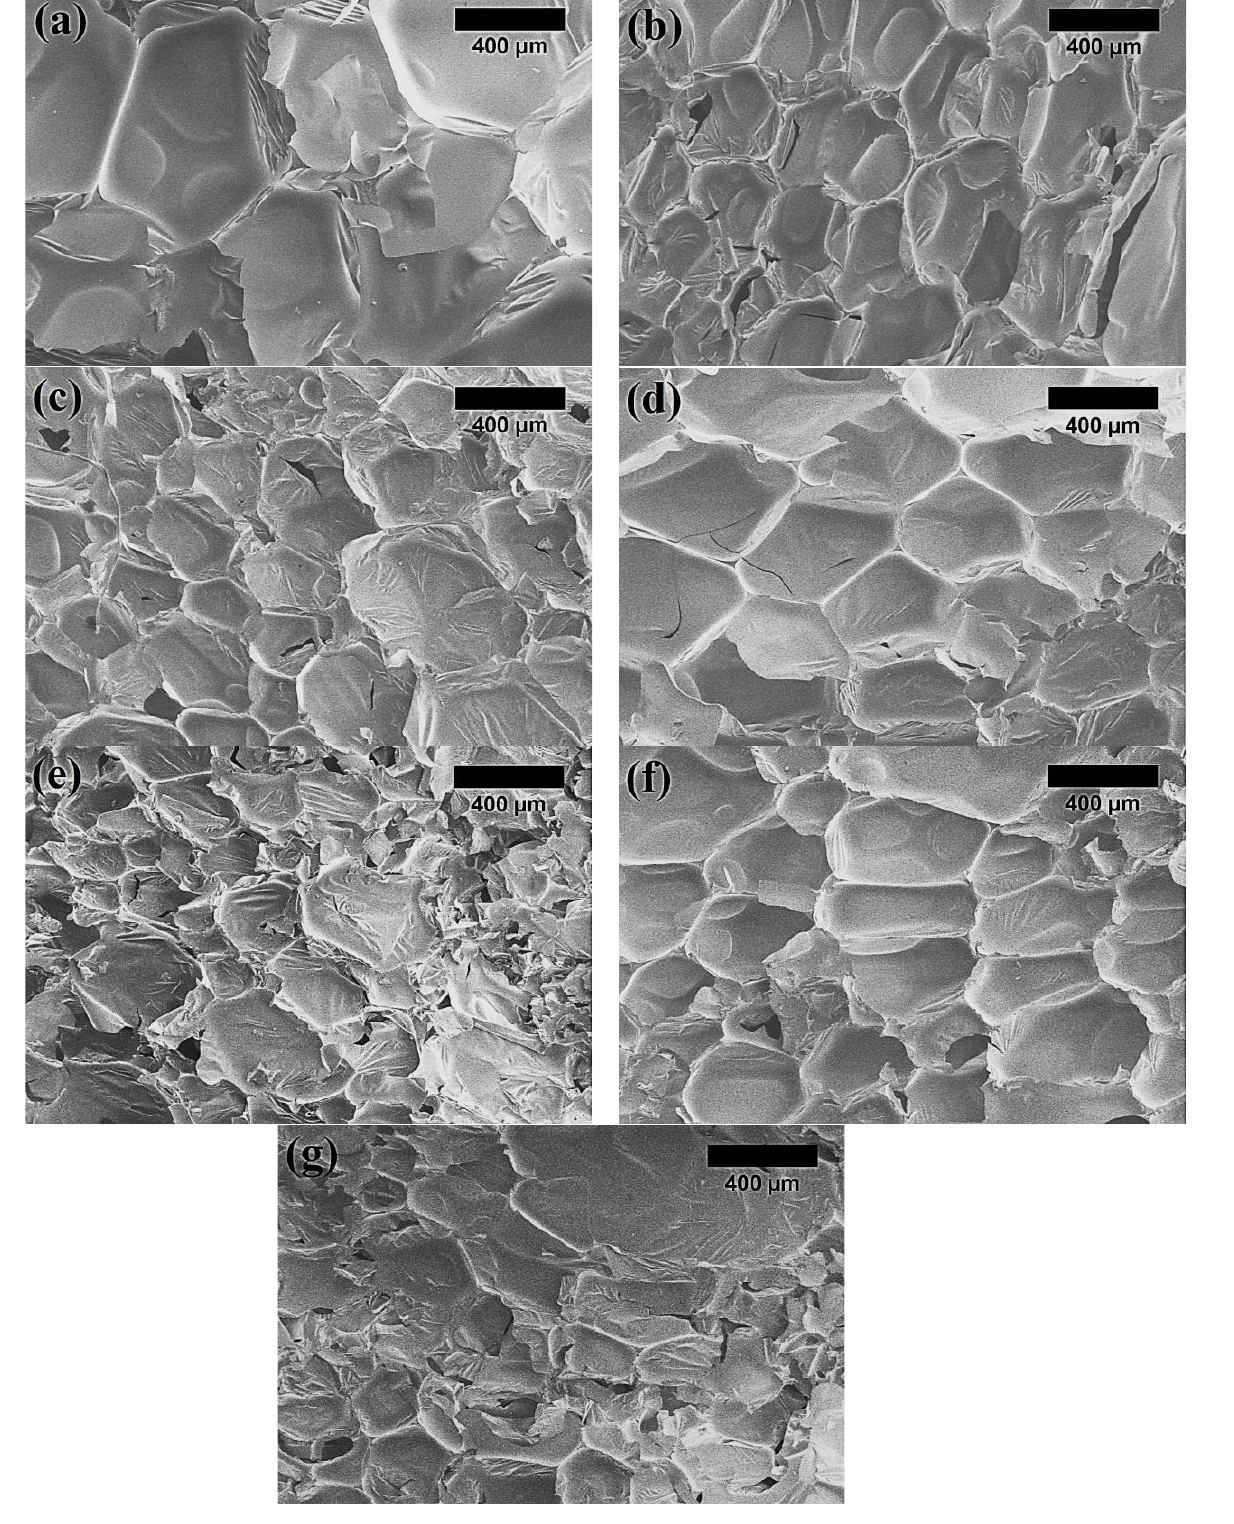
Figure 4. Microstructure of bioPUR foams (magnification × 100): ( a ) control bioPUR; ( b ) bioPUR with 5 wt.% LigW; ( c ) bioPUR with 10 wt.% LigW; ( d ) bioPUR with 5 wt.% LigW/LG 1:1; ( e ) bioPUR with 10 wt.% LigW/LG 1:1; ( f ) bioPUR with 5 wt.% LigW/LG 1:2; ( g ) bioPUR with 10 wt.% LigW/LG 1:2.